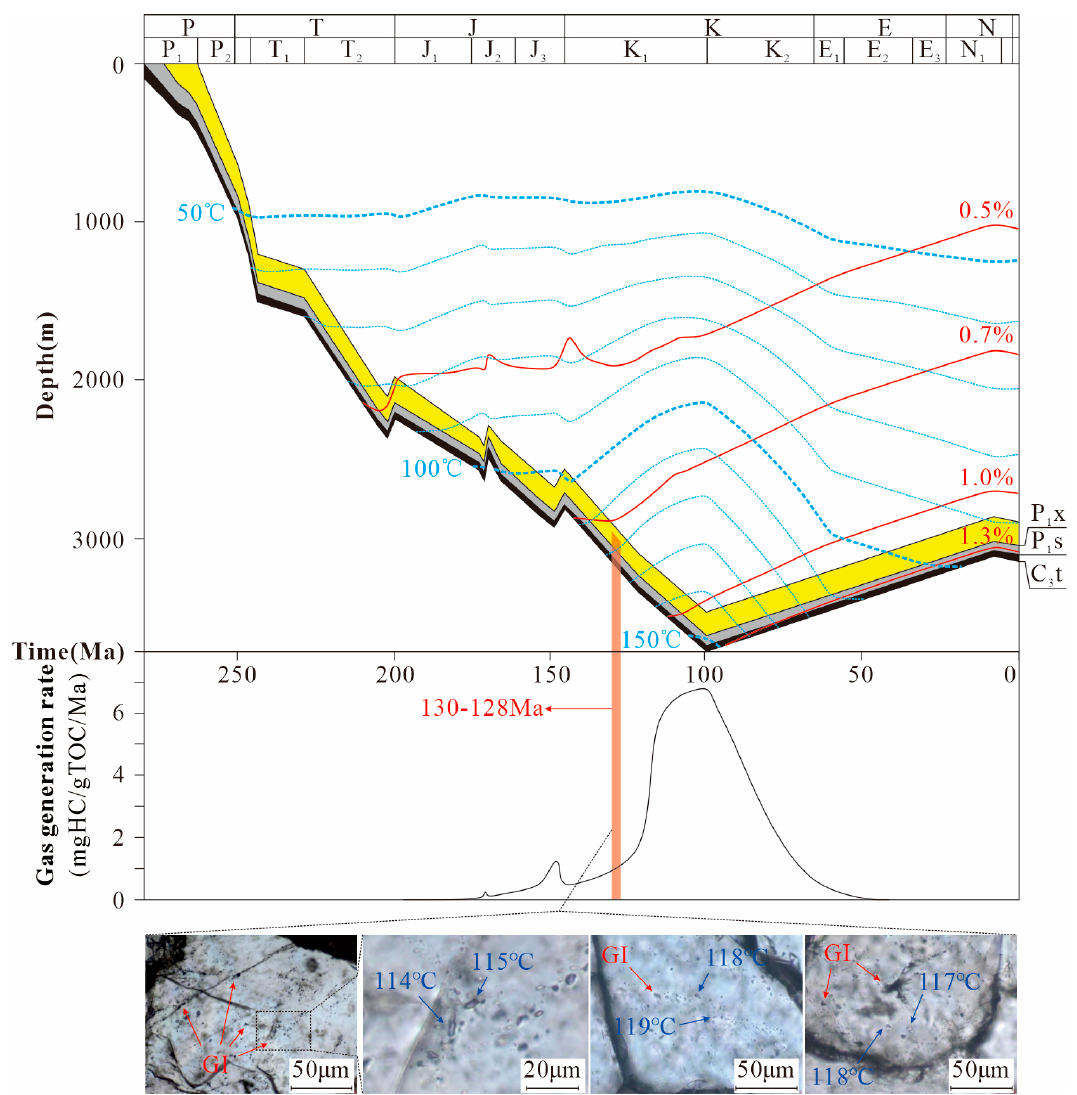
Figure 10. Plots showing the burial and thermal evolution histories, and gas generation and charging histories of well